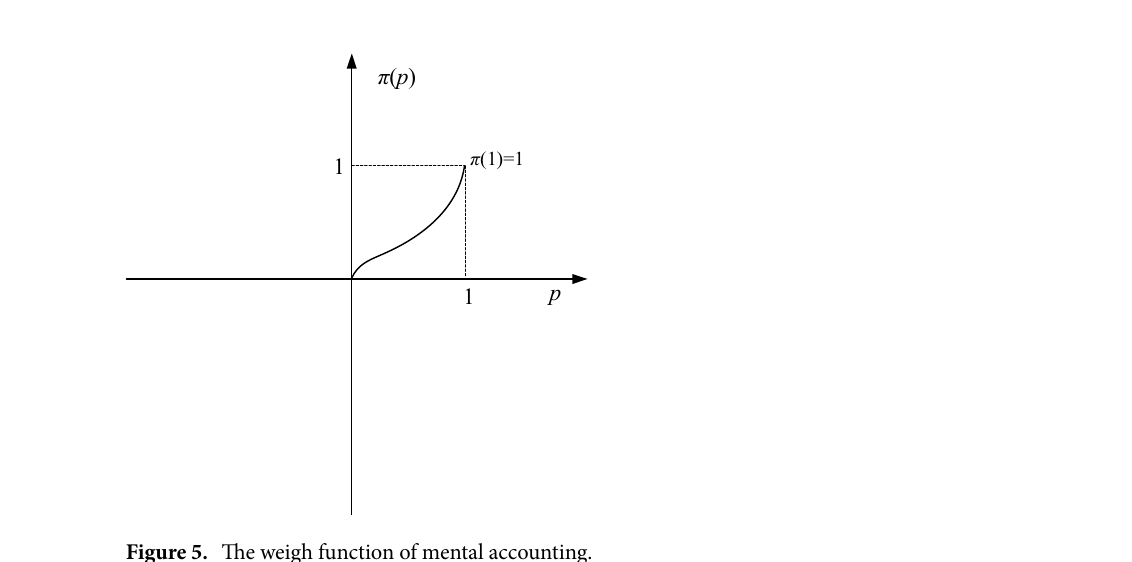
Figure 4. The value functions of cost and income mental accounting.